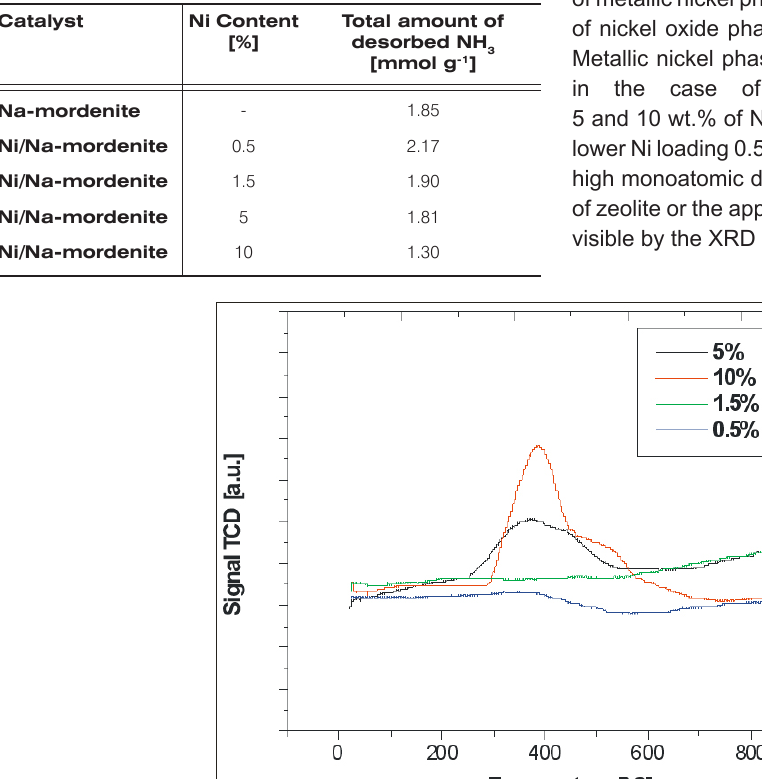
Table 1. TPD-NH results for support (Na-mordenite) and catalytic 3 systems.